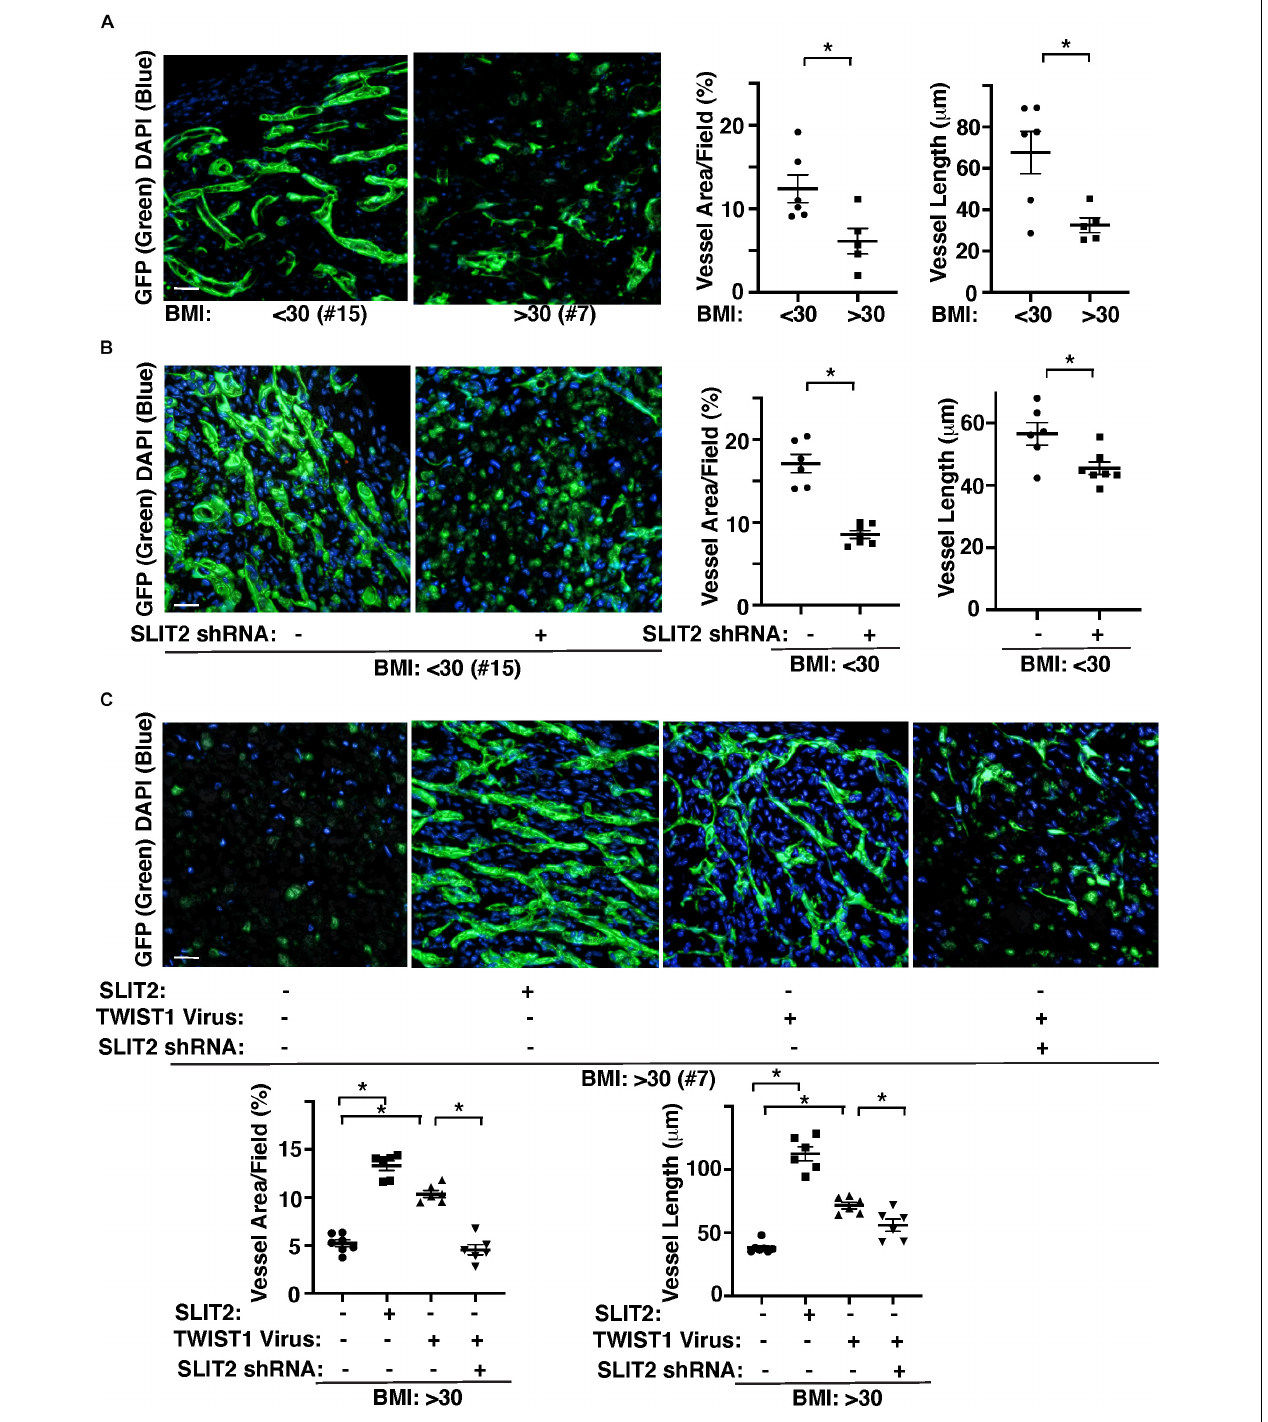
FIGURE 4 | TWIST1-SLIT2 signaling mediates obesity-dependent inhibition of vascular formation in the gel subcutaneously implanted on mice. (A) 3D reconstructed immunofluorescence (IF) images showing GFP-labeled vascular formation and DAPI in the fibrin gel supplemented with GFP-labeled lean (BMI < 30, clone #15) vs. obese (BMI > 30, clone #7) human adipose ECs and subcutaneously implanted on NSG mice for 7 days. Scale bar, 50 µ m. Graphs showing vascular area and average vessel length in the gel ( n = 5–6, mean ± SEM, * p < 0.05). (B) 3D reconstructed IF micrographs showing GFP-labeled vascular formation and DAPI in the fibrin gel supplemented with GFP-labeled lean human adipose ECs (clone #15) treated with lentivirus encoding SLIT2 shRNA and subcutaneously implanted on NSG mice for 7 days. As a control, lean human adipose ECs were treated with control virus. Scale bar, 50 µ m. Graphs showing vascular area and average vessel length in